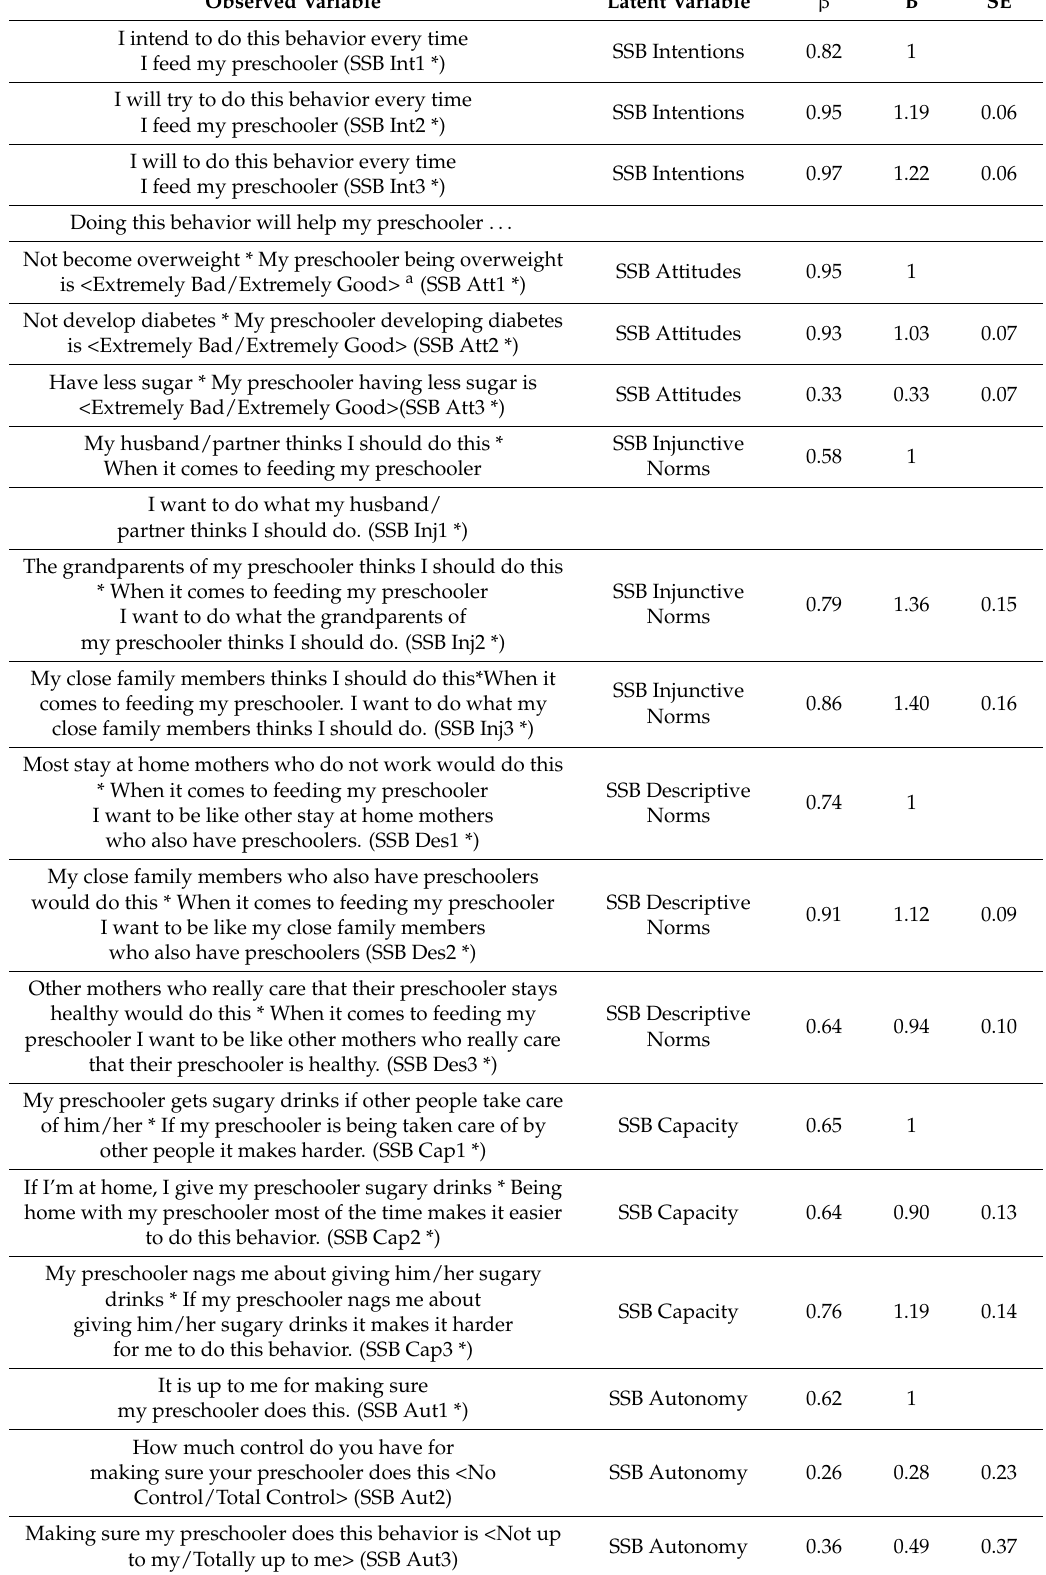
Table 1. Standardized ( β ) and unstandardized ( B ) coefficients for CFA analysis for sugar-sweetened beverage (SSB) monitoring